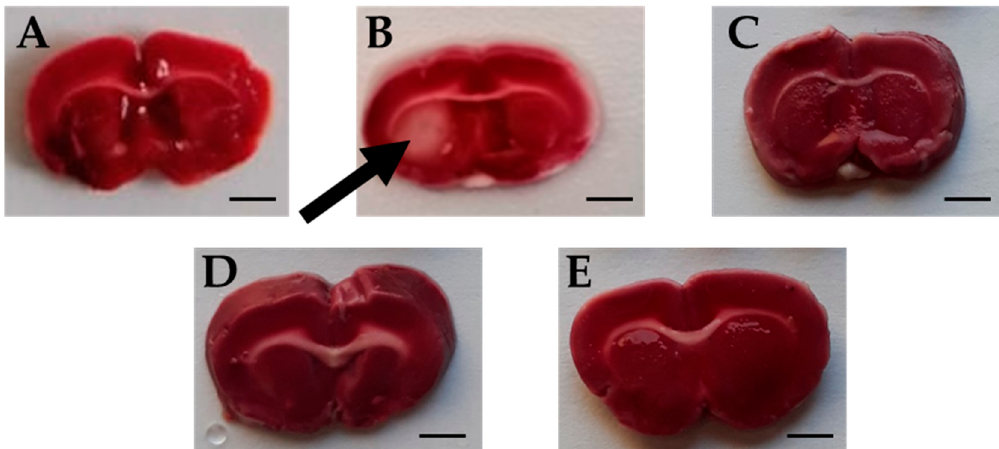
Figure 7. Rat brain sections stained by triphenyltetrazolium chloride (TTC). Images of brain sections ( A – E ) correspond to Sham (n = 6), Ischemic (n = 11), Combination (n = 10), Candesartan (n = 5), and Eucalyptus (n = 5) groups respectively, 14 days after right common carotid artery ligation. Images shown are representative of sections observed for each group. White brain area corresponding to damages caused by ischemia is indicated by an arrow. The red staining sections corresponded to normal non-ischemic areas. Bar scale = 3 mm.